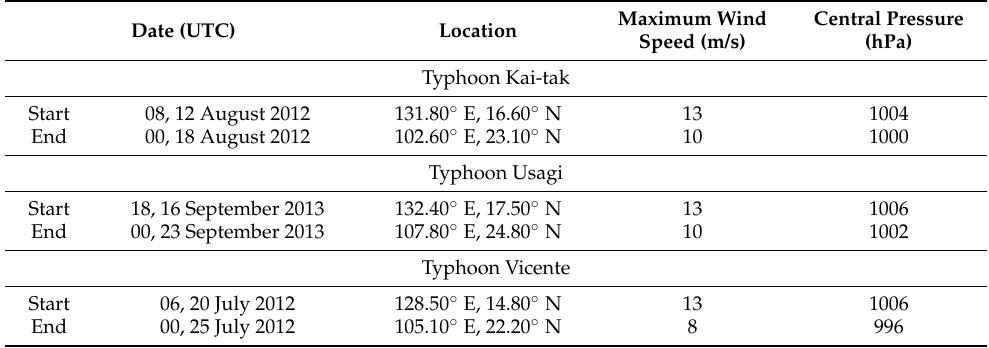
Table 2. Start and end points of the time periods in three typhoon